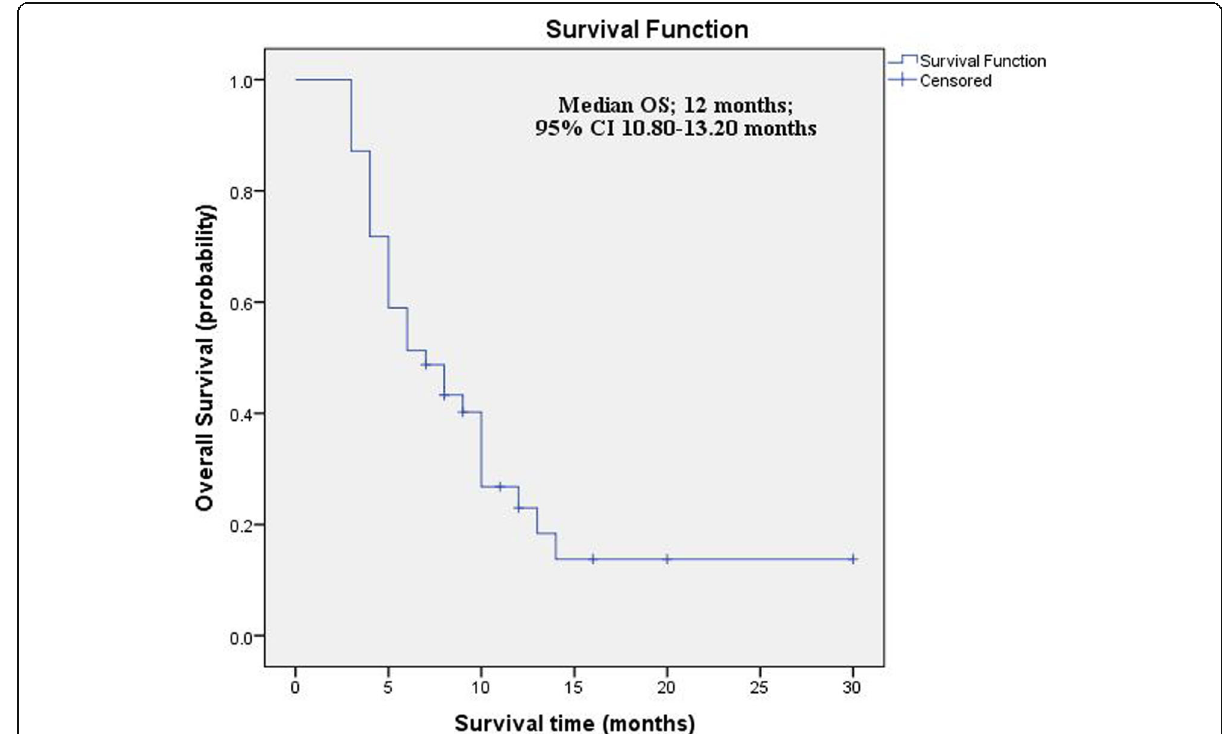
Fig. 4 Kaplan-Meier plot: overall survival. CI confidence interval, OS overall survival